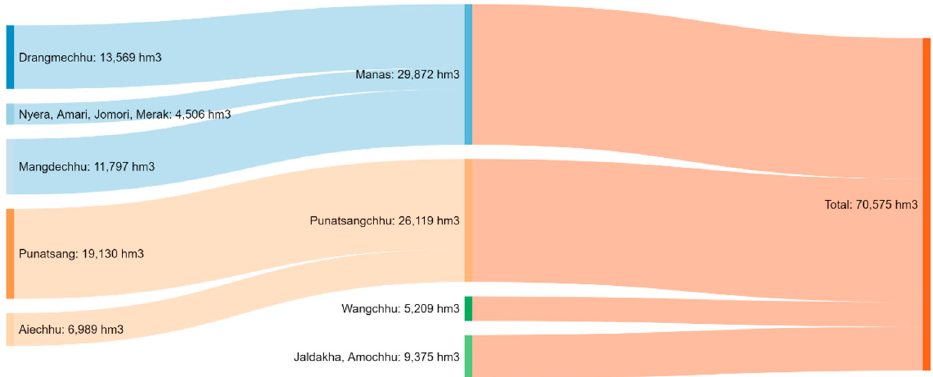
Figure 5. Annual flow of main rivers in Bhutan (Source: National Environment Commission and Katel, O. N. et al. [43,82]).